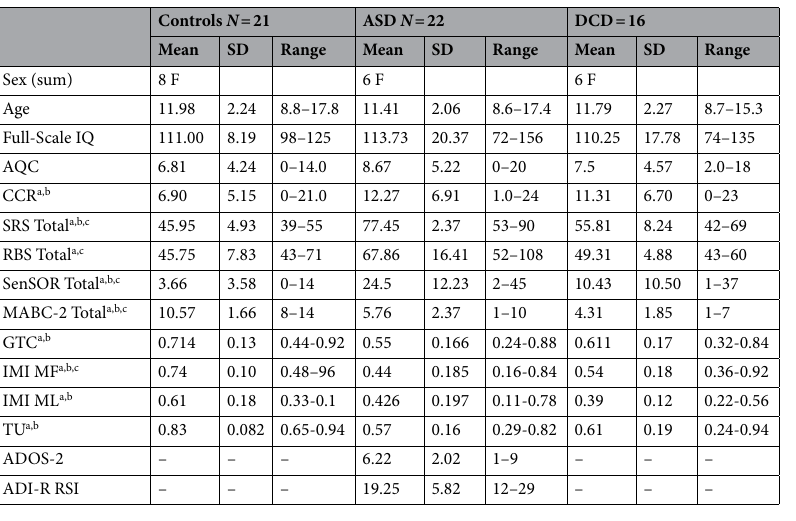
Table 1. Group Demographics. Table of sample demographics. a = TD > ASD; b = TD > DCD; c = ASD > DCD at p < .05; AQC = Alexithymia Questionnaire for Children 2-factor Total; SRS Total = Social Responsivity Scale Total; RBS Total = Repetitive Behaviors Scale Total; SenSOR Total = Sensory Over-Responsivity Scale Total; MABC-2 Total = Movement Assessment Battery for Children-2 Total Scorel; CCR = Connors Child Report; GTC = gesture to command; IMI MF = imitation of meaningful gestures; IMI ML = imitation of meaningless gestures; TU = tool use; ADOS-2 = Autism Diagnostic Observational Scale-2 Comparison Score; ADI-R RSI: Autism Diagnostic Interview Revised, Reciprocal Social Interactions